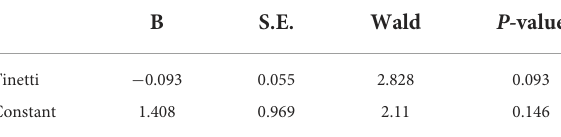
TABLE 4 Results of the binary logistic regression with falls during the last year as the dependent variable (dichotomous: YES/NO); Tinetti score as predictor.